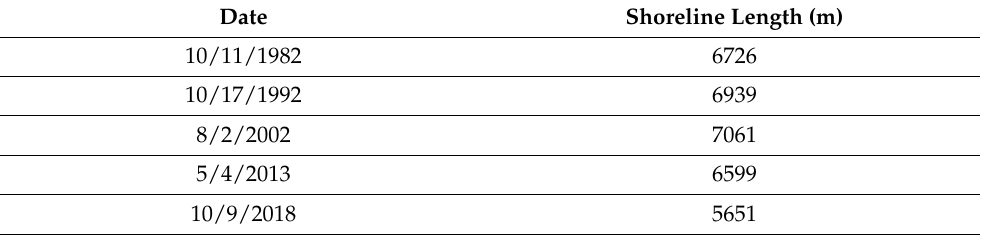
Table 6. Shoreline length data of Segment C.